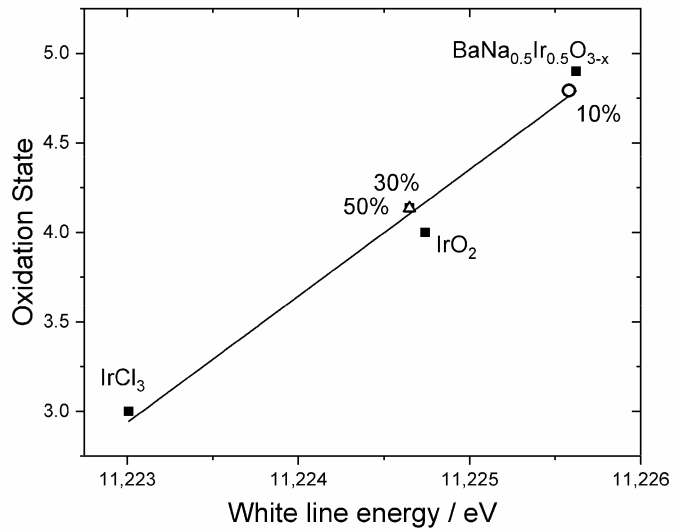
Figure 6. Oxidation states of Ir-substituted NaTaO 3 materials labelled according to the proportion of Ir added in synthesis, plotted with reference materials. The line is the linear regression fit to the points from the reference